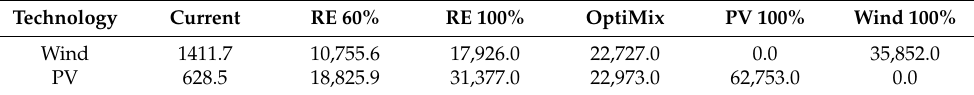
Table 6. Installed capacity in kW of renewable resources in the I-RE municipality